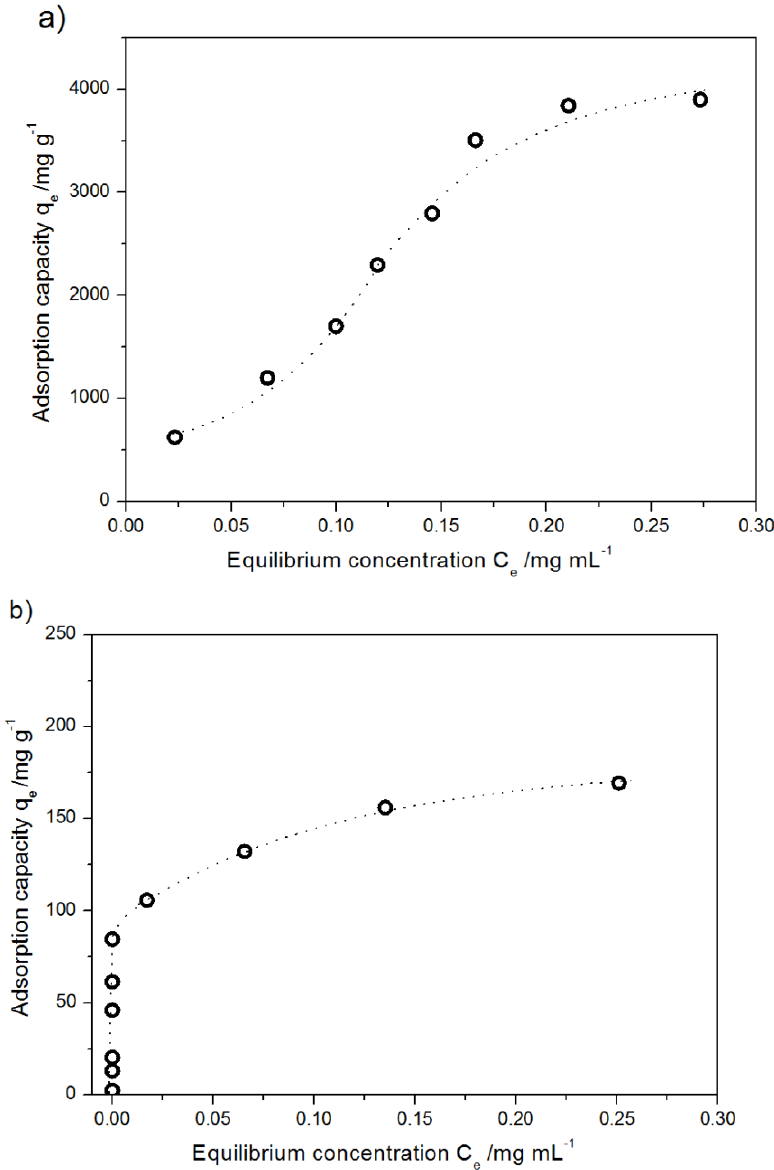
Figure 9. The average adsorption isotherms of DOX at 298.15 K on ( a ) modified MWCNTs ( b ) pristine MWCNTs. Data are presented as mean ± SD ( n = 3).